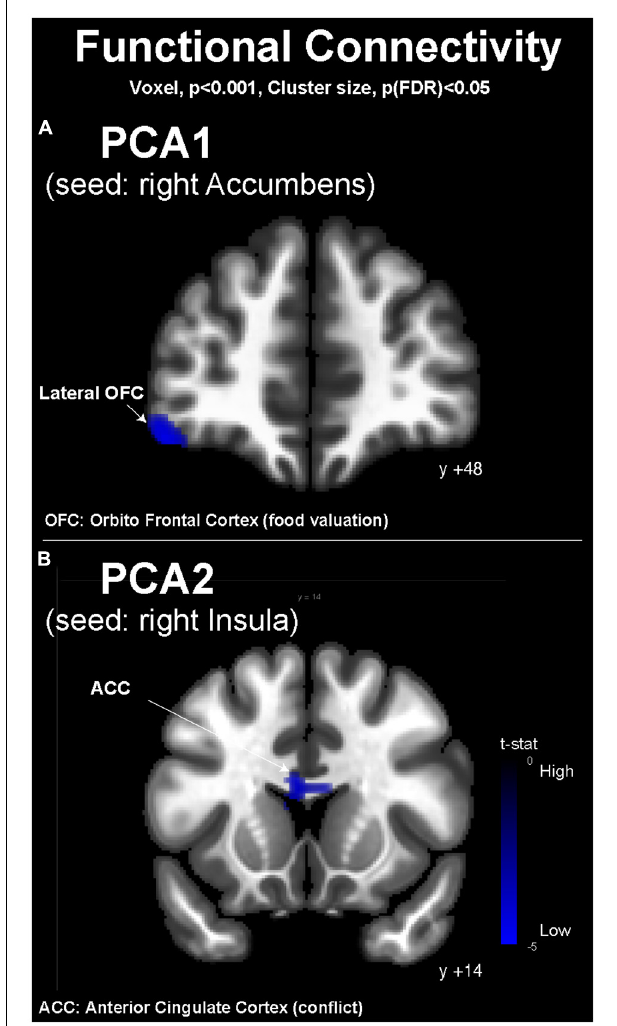
FIGURE 4 | Resting-state functional magnetic resonance imaging functional connectivity maps (conn toolbox). (A) Depending on the PCA1 values with the right accumbens as seed and (B) depending on PCA2 values with the right insula as seed. MNI coordinates are indicated for each coronal slice. OFC, orbitofrontal cortex; ACC, anterior cingulate